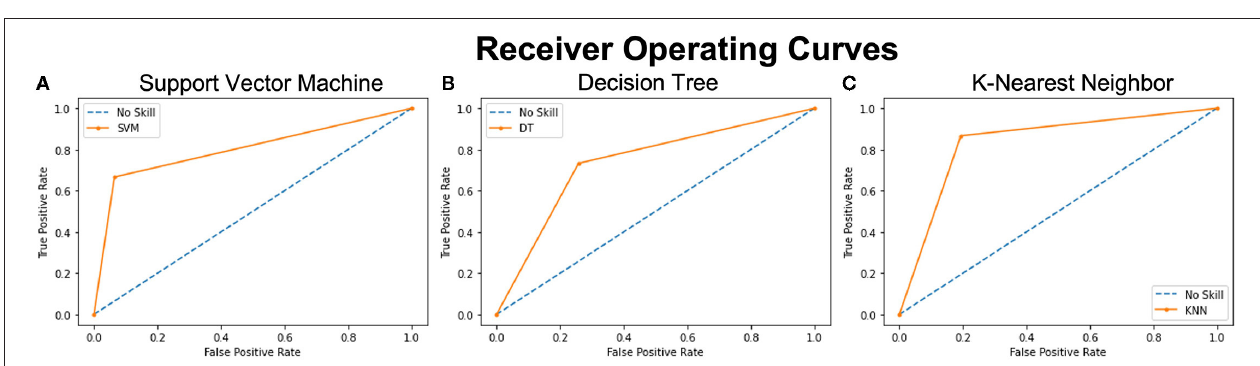
FIGURE 3 | ROC curves of 3 analyzed models representing the prediction accuracy of each. The orange curves show the trade-off between sensitivity (True Positive Rate – TPR on y axis) and specificity (False Positive Rate – FPR on x axis). Curves closer to the left-top corner indicate better performance. The blue dashed lines – No Skill, are the baseline diagonals (FPR = TPR), where classifiers are expected to give point lying on this line. The closer the orange curves are to the 45 degrees blue diagonal, the less accurate the model is. (A) Shows the ROC curve of the SVM model with the highest accuracy score and the closest tip to the y-axis and the left-top corner. (B) shows the ROC curve of the Decision Tree analysis with the lowest accuracy score and (C) shows the ROC curve of the KNN model with the second highest accuracy